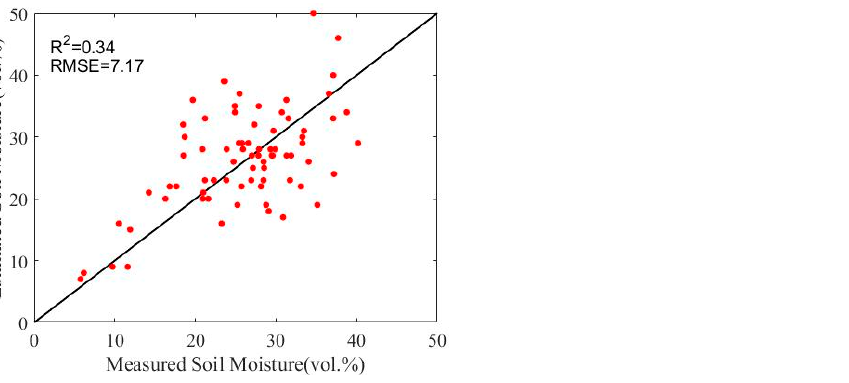
Figure 9. Scatterplots between the measured and predicted SMC values on the validation set based on RVI (WCM).